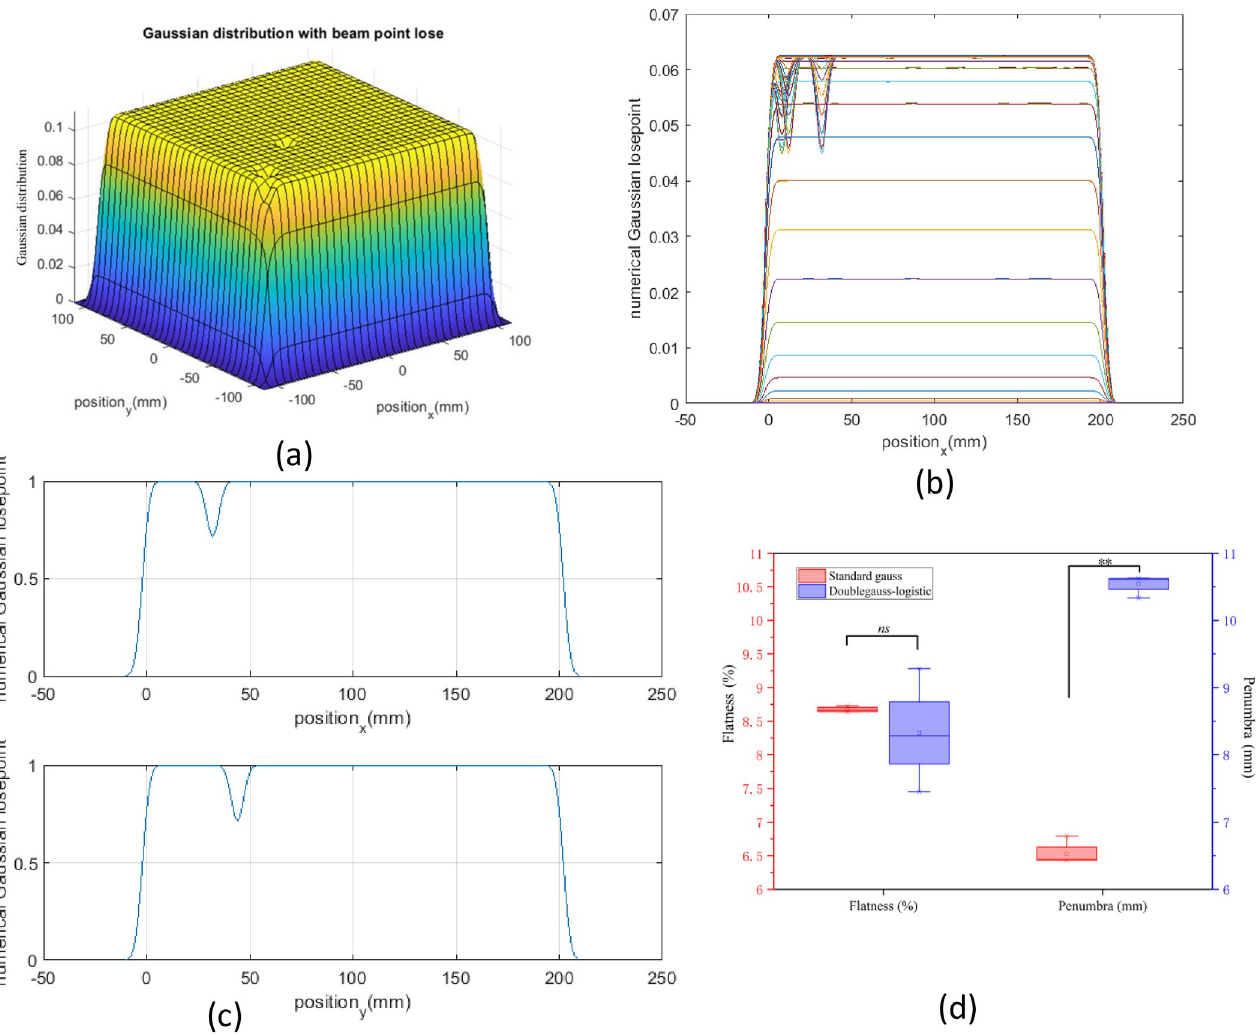
Fig 8. The influence of random loss points on flatness and penumbra. (a) 3D Gaussian distribution with beam point loss was plotted by MATLAB. (b) and (c) The projection of Gaussian distribution was drawn in both x- and y-directions. (d) The calculated flatness and penumbra were compared in the standard Gaussian model and the double Gaussian-logistic model. p values: �� < 0.01. Non-significant differences are indicated as n.s.